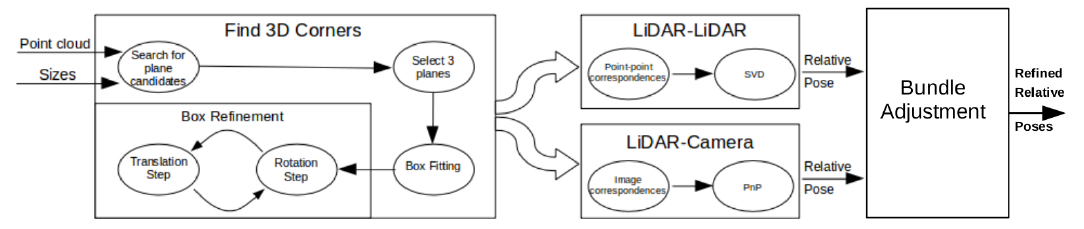
Figure 1. Outline of the calibration. Corners of the calibration box are extracted first from LiDAR point cloud. Then, LiDAR-LiDAR or LiDAR-camera pairs are calibrated using corresponding